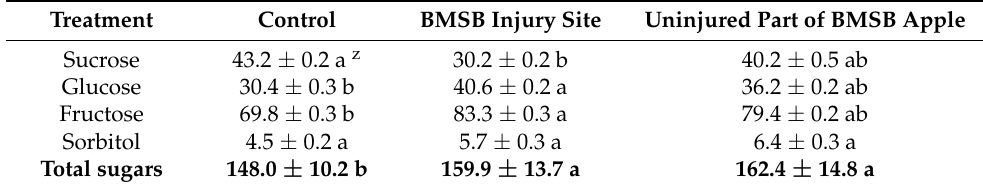
Table 1. Individual and total sugar contents (g/kg FW, mean ± SE) of control fruit, and injured and uninjured sites on BSMB-injured apple fruits.